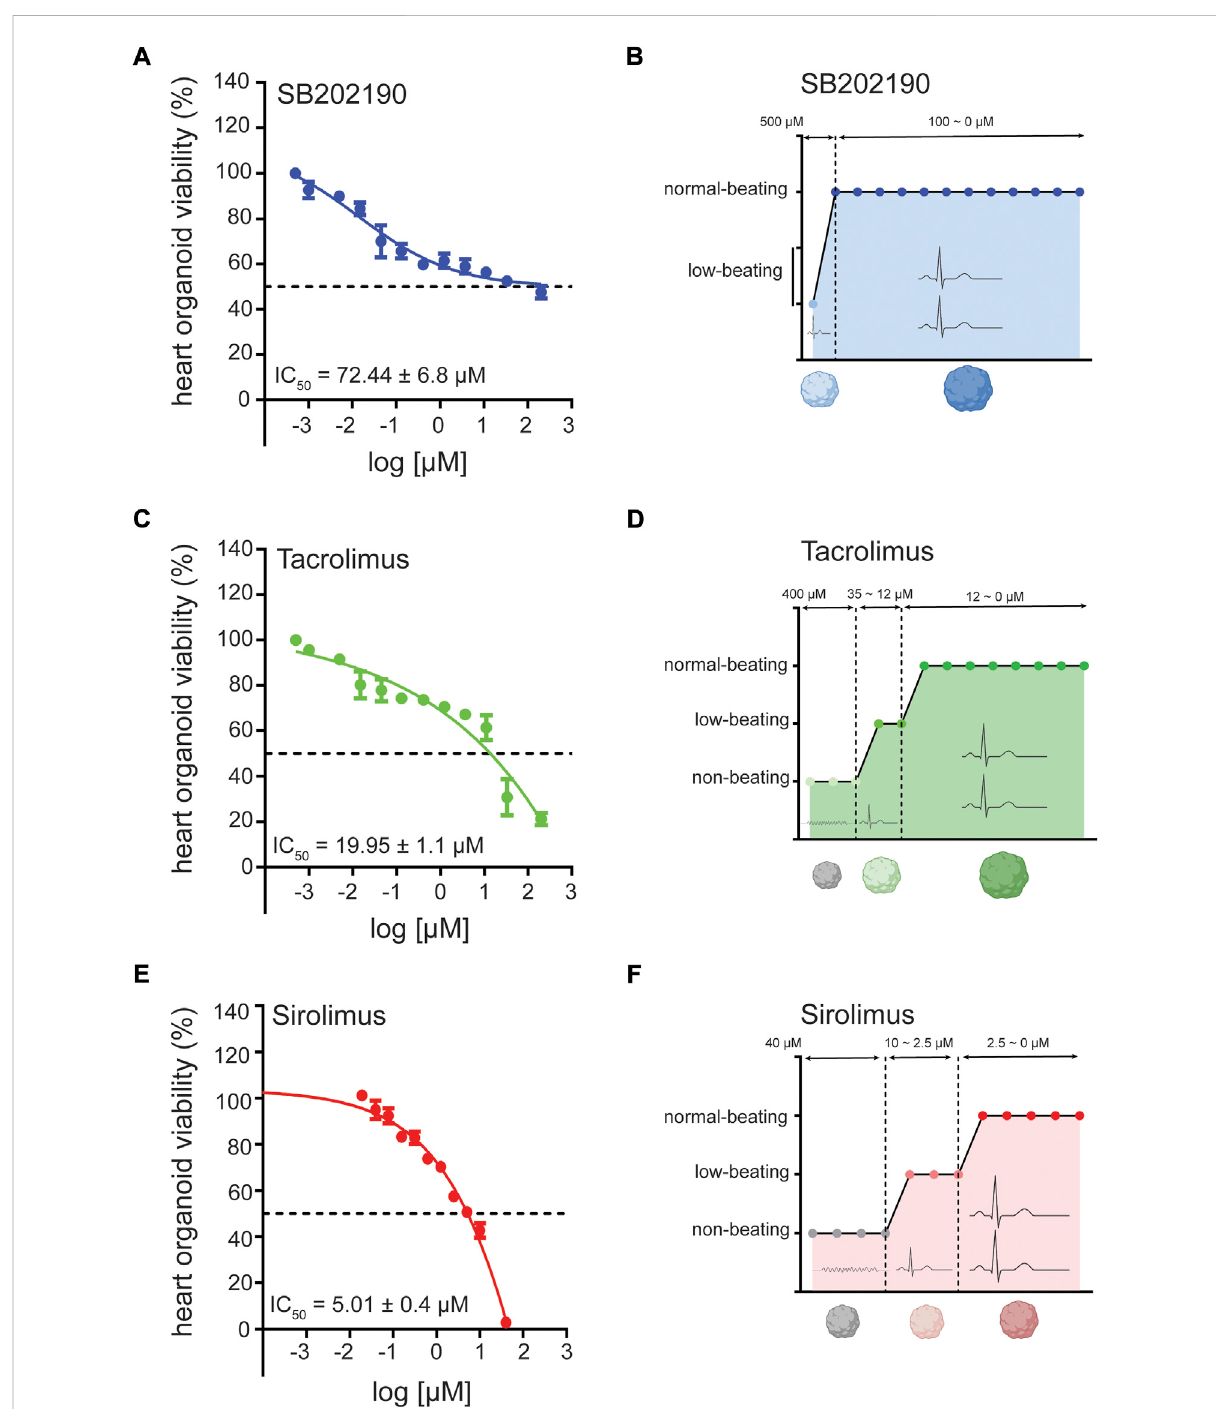
FIGURE 3 Cardiotoxicity of anti fi brotic compounds in human heart organoids (hHOs) for disease modeling. (A) MTT assay showing hHO cellular viability and IC50 after 96 h of treatment with SB202190 in decreasing concentrations at fi xed 1:2 dilutions from 10 mM. (B) compound dose-pro fi ling for electrophysiological beating perturbation in hHO under decreasing concentrations of SB202190 for 96 h. (C) MTT assay showing hHO cellular viability and IC50 after 96 h of treatment with Tacrolimus in decreasing concentrations at fi xed 1:2 dilutions from 10 mM. (D) compound dose- pro fi ling for electrophysiological beating perturbation in hHO under decreasing concentrations of Tacrolimus for 96 h. (E) MTT assay showing hHO cellular viability and IC50 after 96 h of treatment with Sirolimus in decreasing concentrations at fi xed 1:2 dilutions from 2 mM. (F) compound dose- pro fi ling for electrophysiological beating perturbation in hHO under decreasing concentrations of Sirolimus for 96